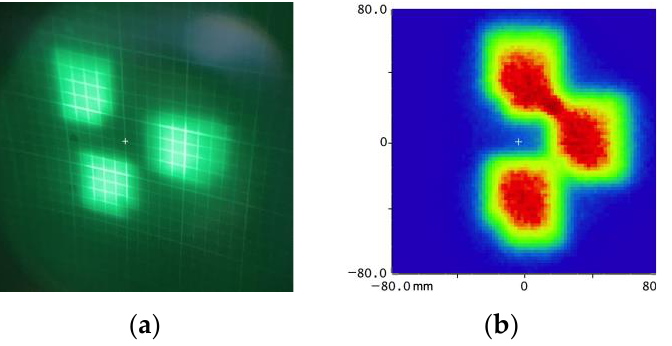
Figure 9. ( a ) Displacement by lens position deviation in the experiment (grid board scale: 10 mm); ( b ) simulation of each lens position with a 1 mm deviation.